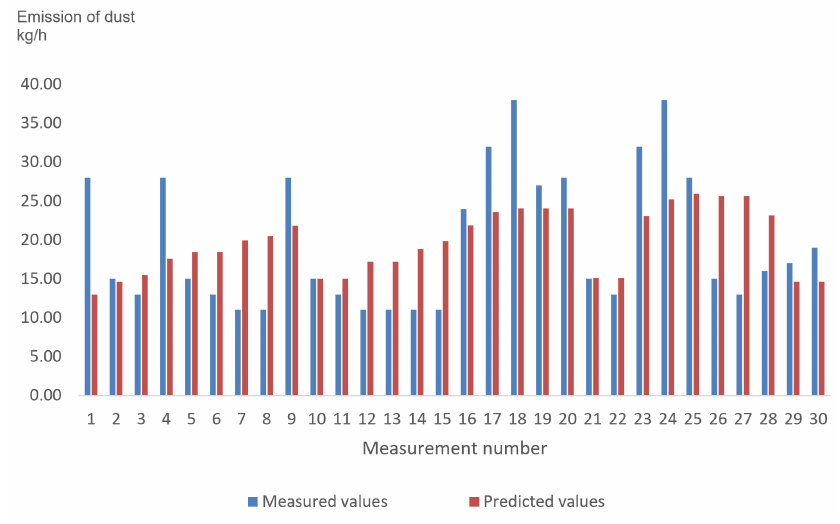
Figure 6. Comparison of the predicted values of the dust emission model with measured values.